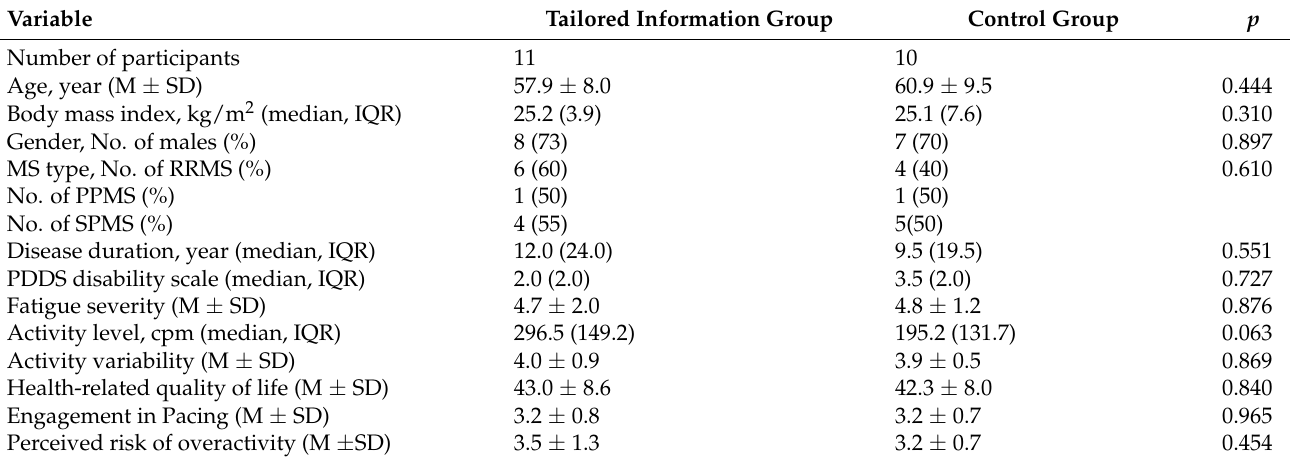
Table 1. Descriptive Characteristics of